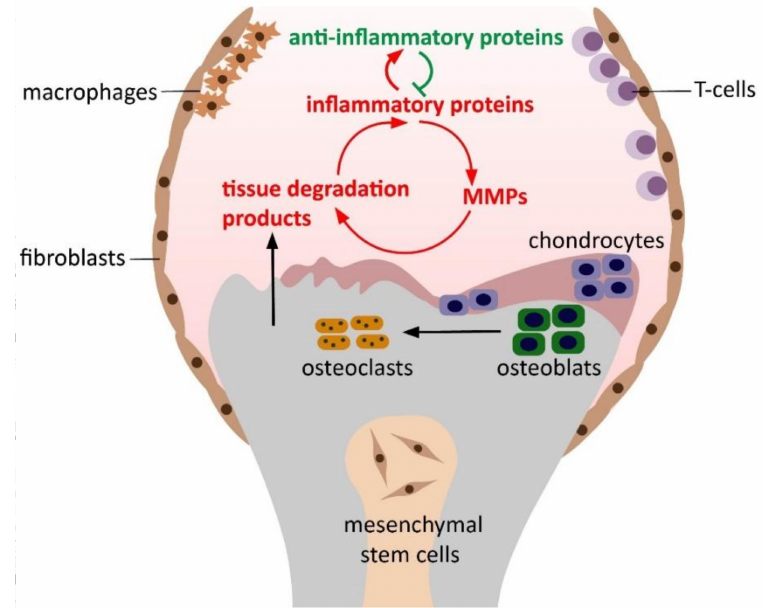
Figure 1. Pathogenesis of osteoarthritis, including the progression of the osteoarthritis (OA) positive feedback loop, including synovial inflammation and tissue degradation. Inflammatory proteins produced mainly by chondrocytes, synovial fibroblasts, and macrophages induce the excess production of tissue-degrading enzymes, such as matrix metalloproteinases. Products of cartilage breakdown are phagocytosed by the synovial cells triggering the release of even more proinflammatory